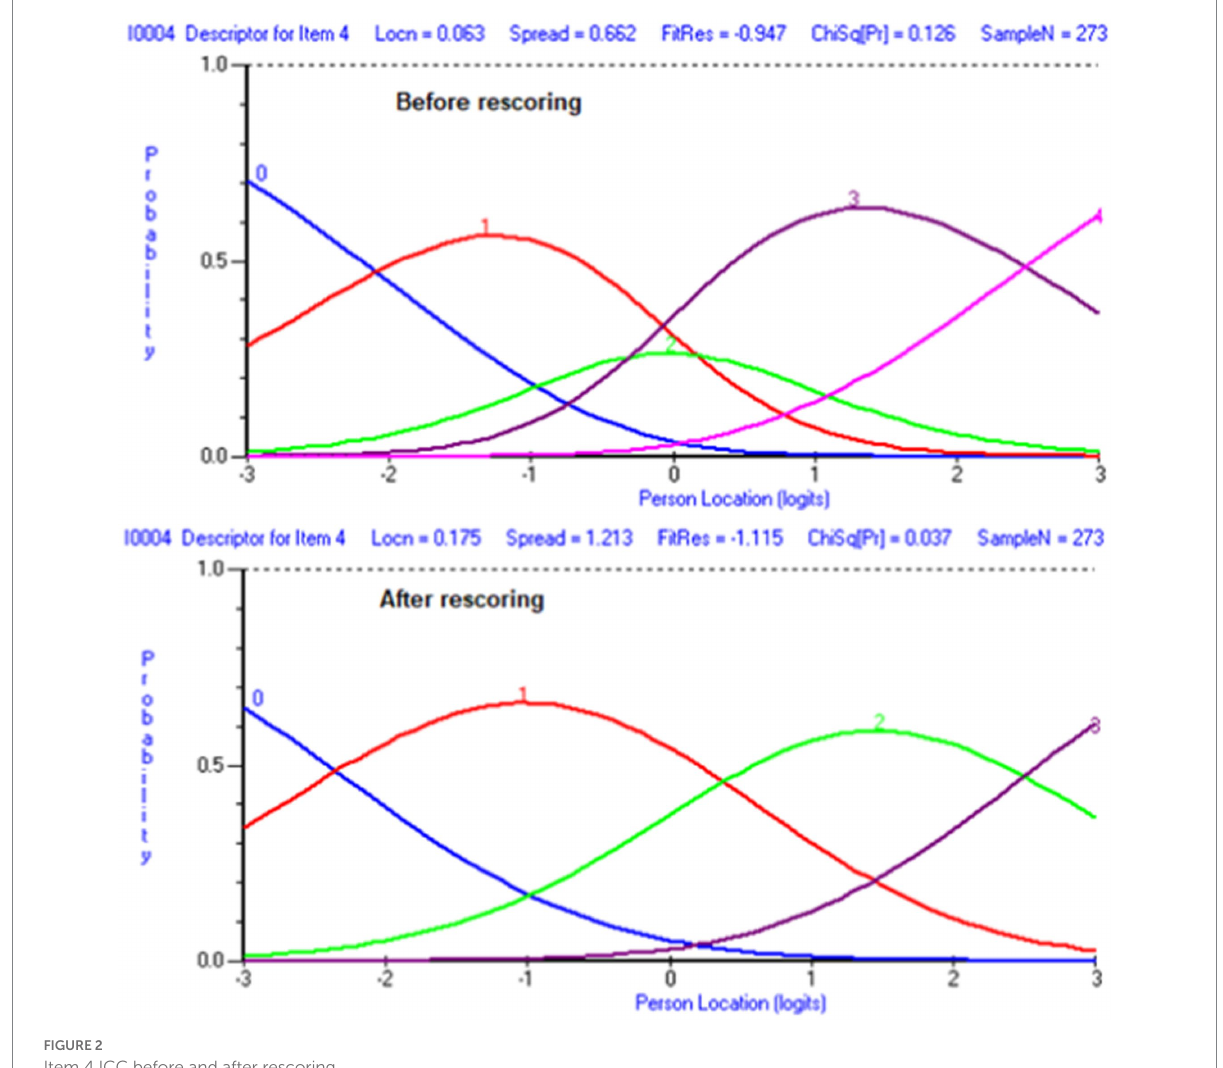
FIGURE 2 Item 4 ICC before and after